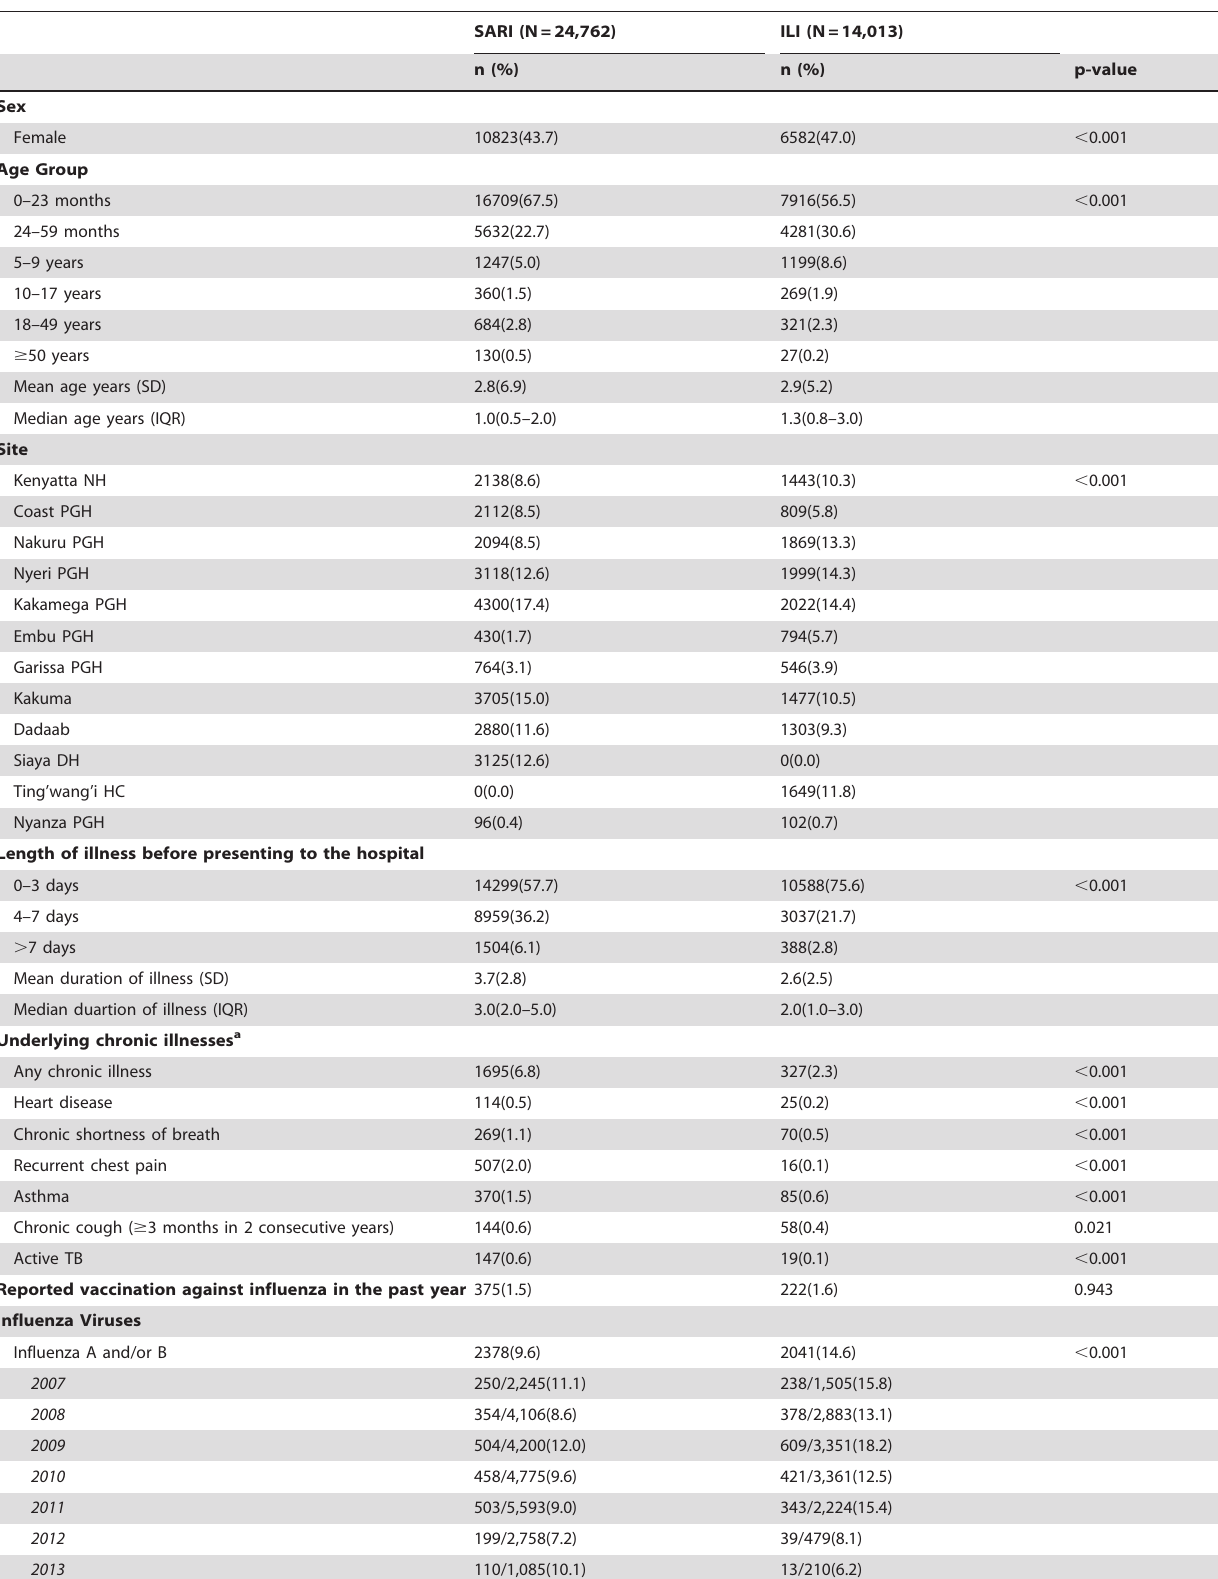
Table 1. Characteristics of patients and comparison of SARI and ILI, Kenya, July 2007–June